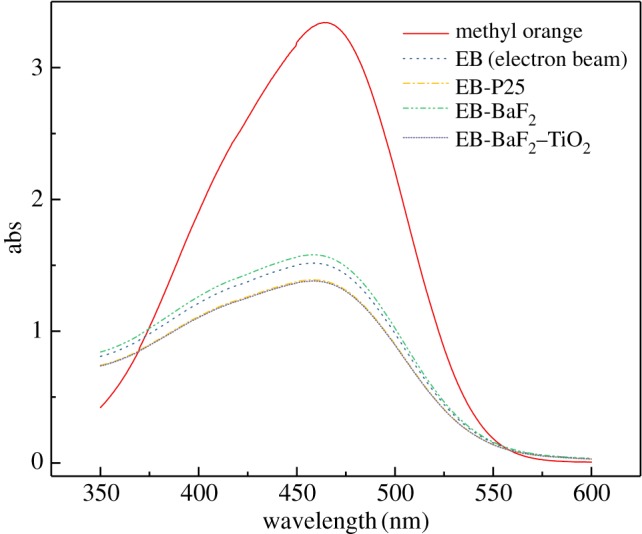
Ultraviolet–visible spectra before and after EB irradiation of methyl orange solutions with different catalysts (CBaF2, CP25: 1 g l−1; C0.75-BaF2–TiO2: 1.75 g l−1).